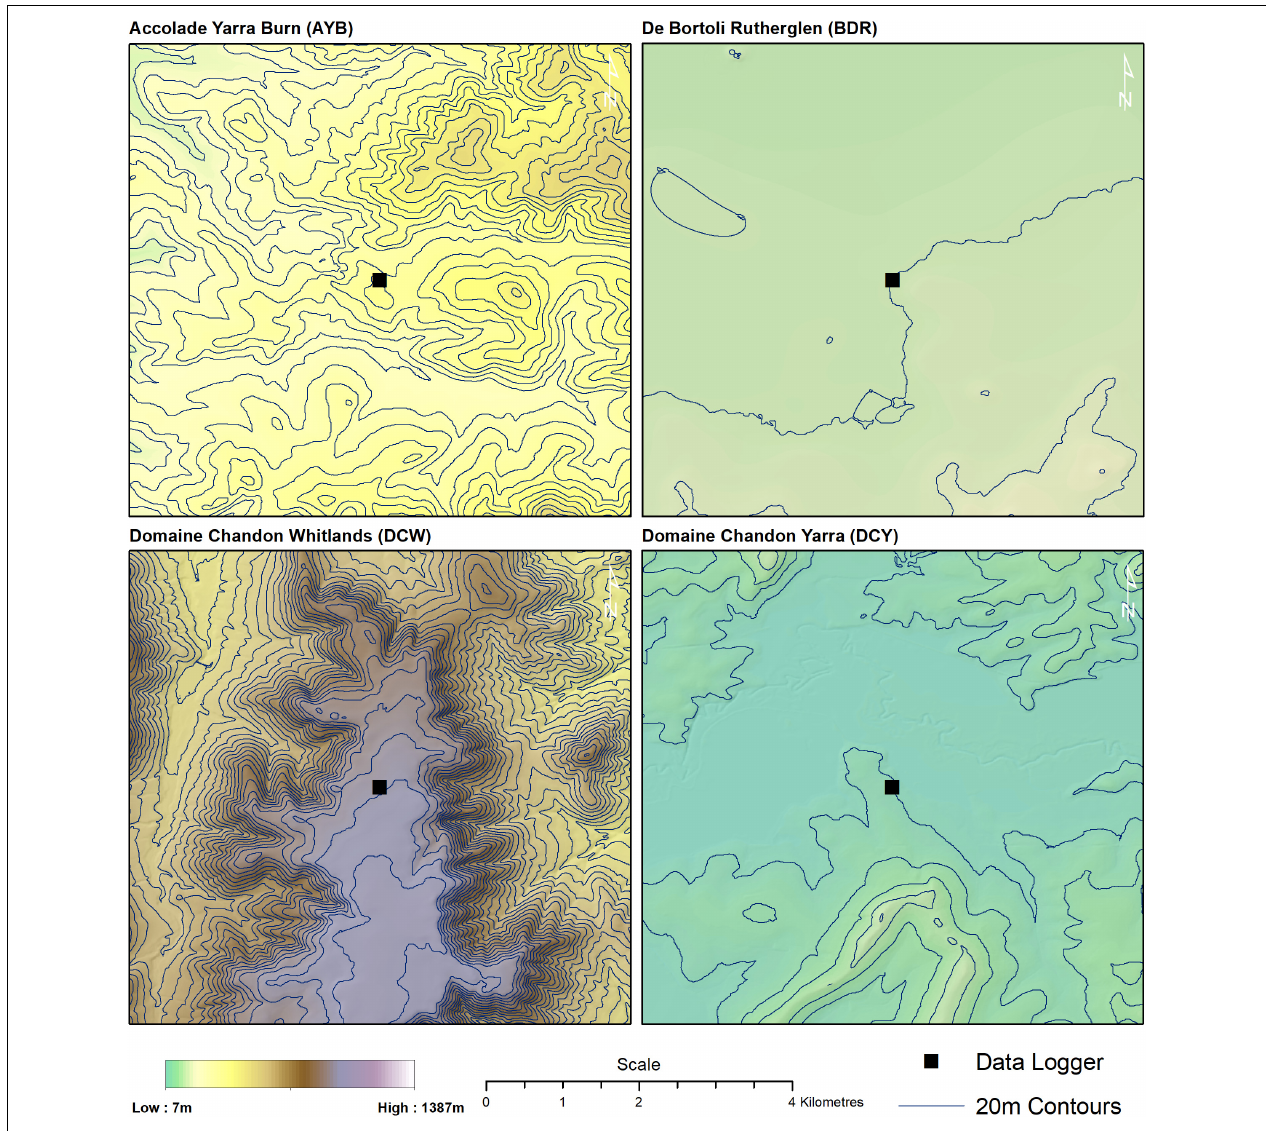
FIGURE 2 | Digital elevation model of vineyard